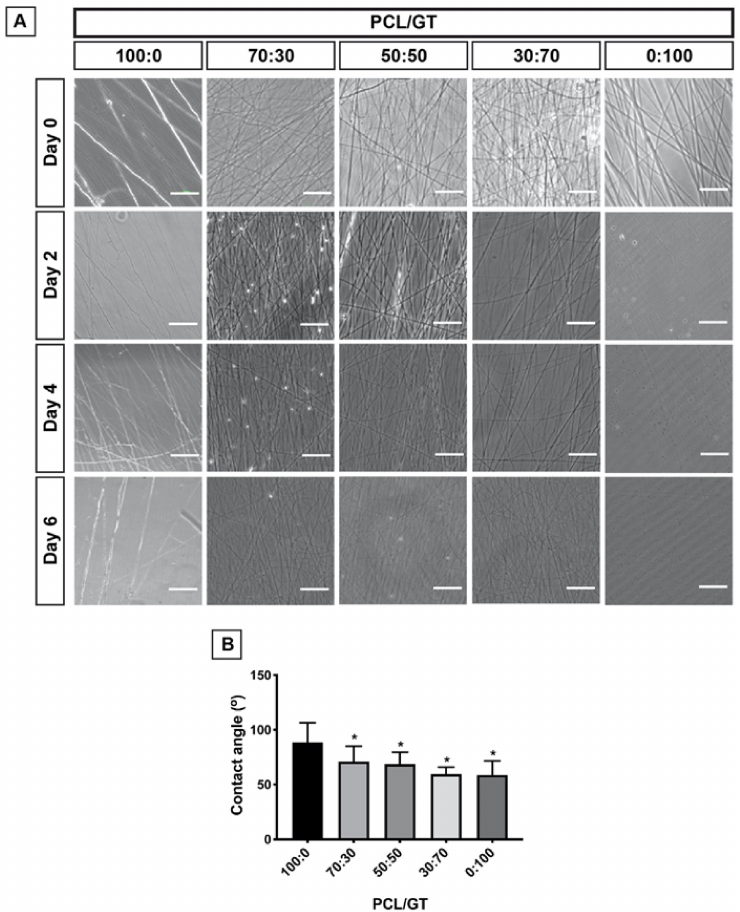
Figure 3. ( A ) Post-immersion morphological investigations of PCL/GT nanofibers in phosphate- buffered saline at different time points. (Scale bar represents 100 µ m). ( B ) The water contact angle of PCL/GT nanofibers. One-way ANOVA with post-hoc Tukey was used for analysis. * p -value (<0.05).